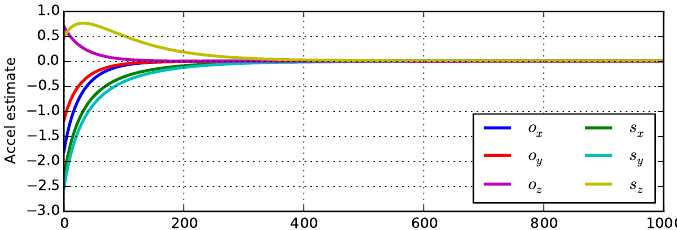
Figure 4. Error of estimated calibration parameters as a function of iteration number. Values at zero indicates perfect estimation.